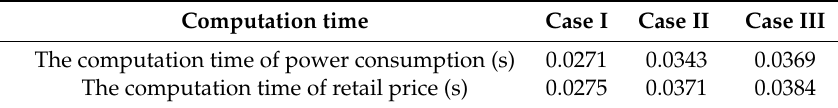
Table 5. The computation time of the pricing regulation